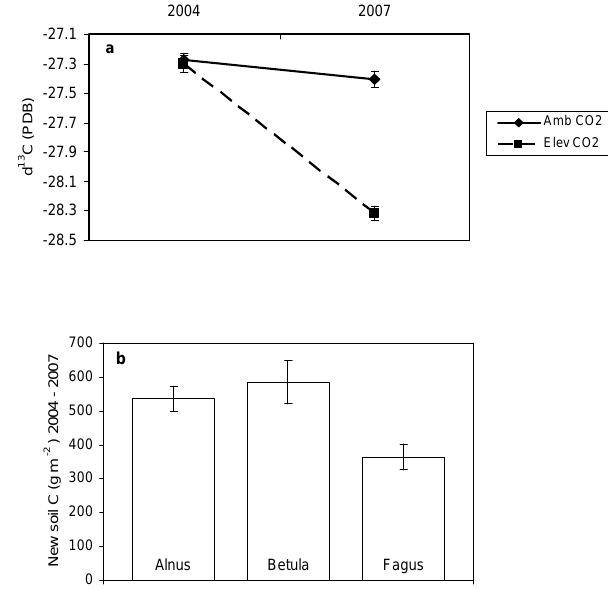
Fig. 3. Change of soil δ 13 C (a) and new soil C (b) in elevated [CO 2 ] plots at 0–10cm depth between October of 2004 and